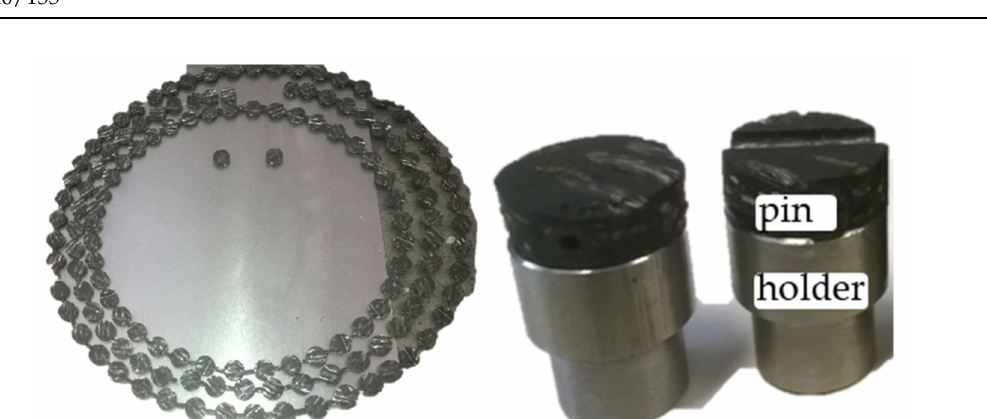
Figure 3. Samples cut from the facing and glued to metal holder-pins for